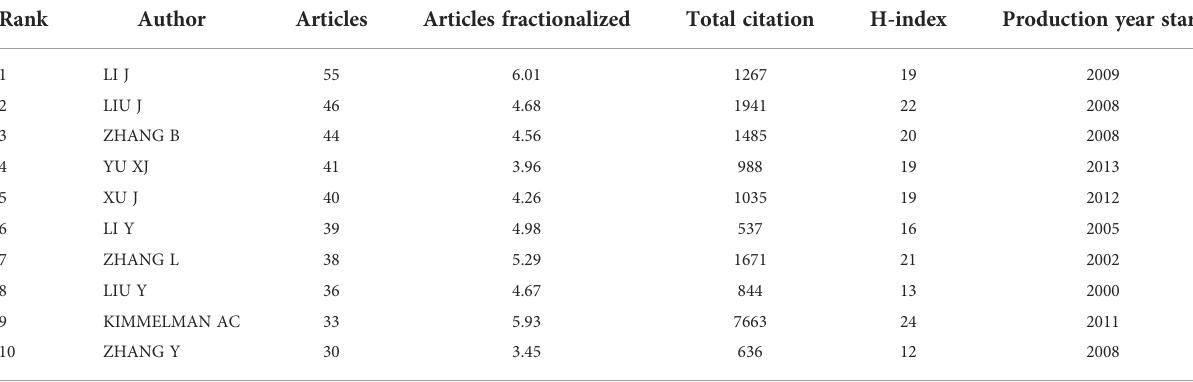
TABLE 2 Top 10 most productive authors in the fi eld of pancreatic cancer metabolism. Rank